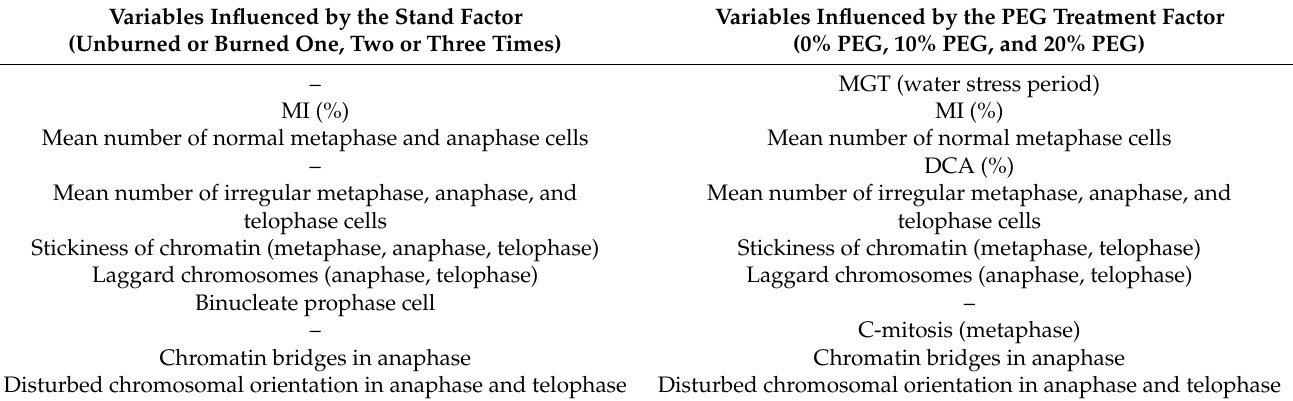
Table 5. Summary of the variables that were significantly influenced by the stand and/or PEG treatment